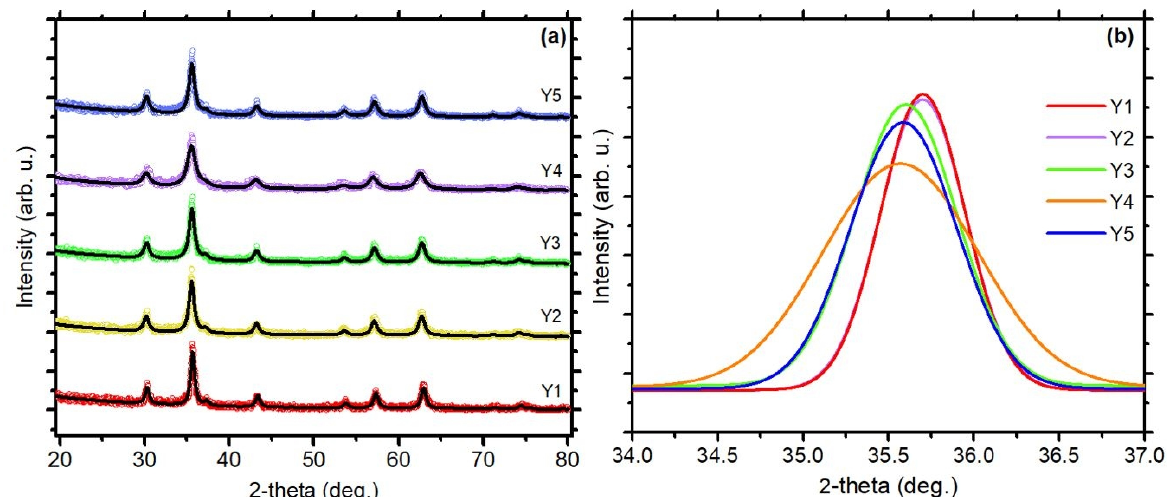
Figure 1. (a) XRD patterns and (b) highest diffraction peaks of the Zn-doped magnetite nanoparticles.